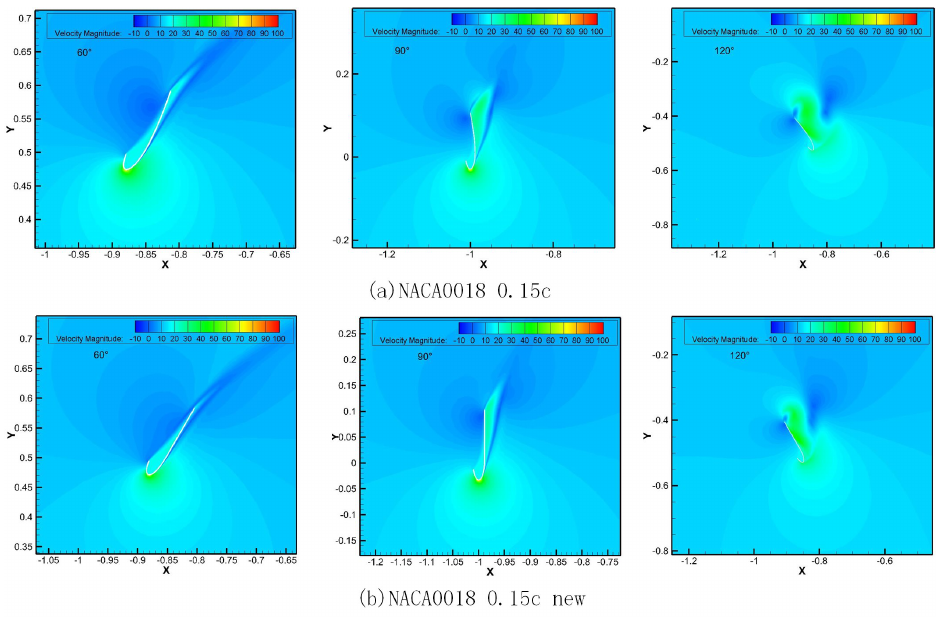
Figure 30. Velocity flow field around J-shaped blade before and after optimization.